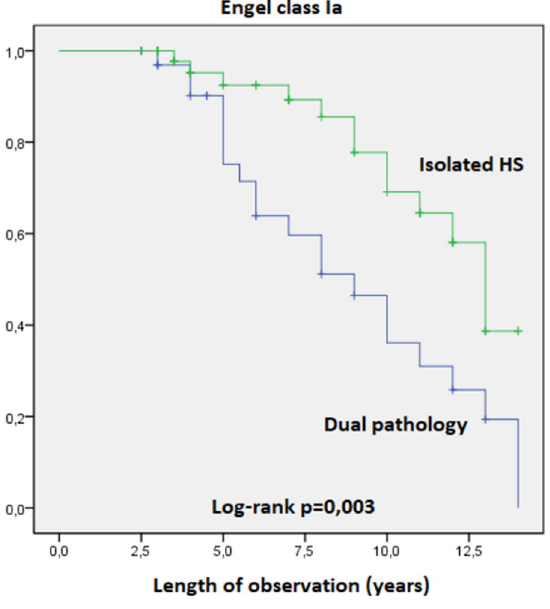
Fig 7. Kaplan-Meier survival curves of patients in Engel class Ia by associated pathologies.